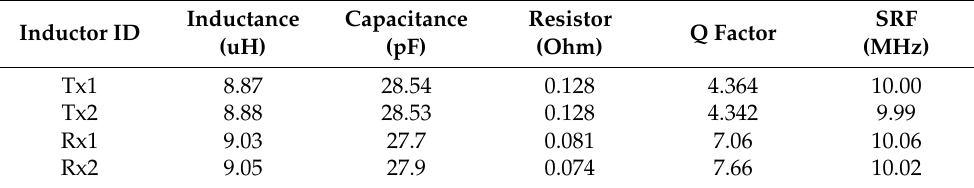
Table 2. Coil specifications used in the WPT experiments in this paper [24].